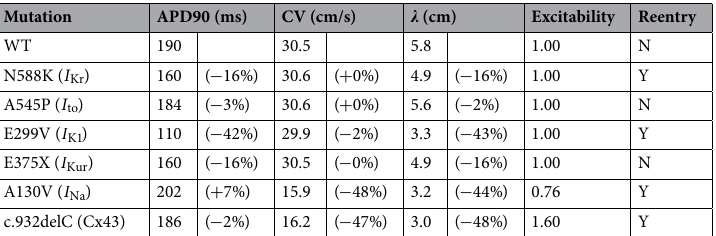
Table 6. Summary of the results of the EMI model simulations of the PV sleeve for WT and six mutations linked to AF. Definitions of the properties are given in the “Definition of excitability and re-entry” and “Defining biomarkers” sections, and the numbers in parentheses report the deviation from WT. The distance around the PV sleeve cylinder (of radius 1.5 cm) is approximately 4.7